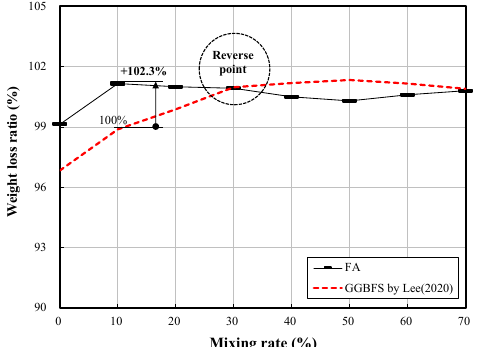
Figure 14. Results of the weight loss rate of OPC and FA compared with GGBFS as measured by Lee (adapted from [26]) in terms of the mixing rate.